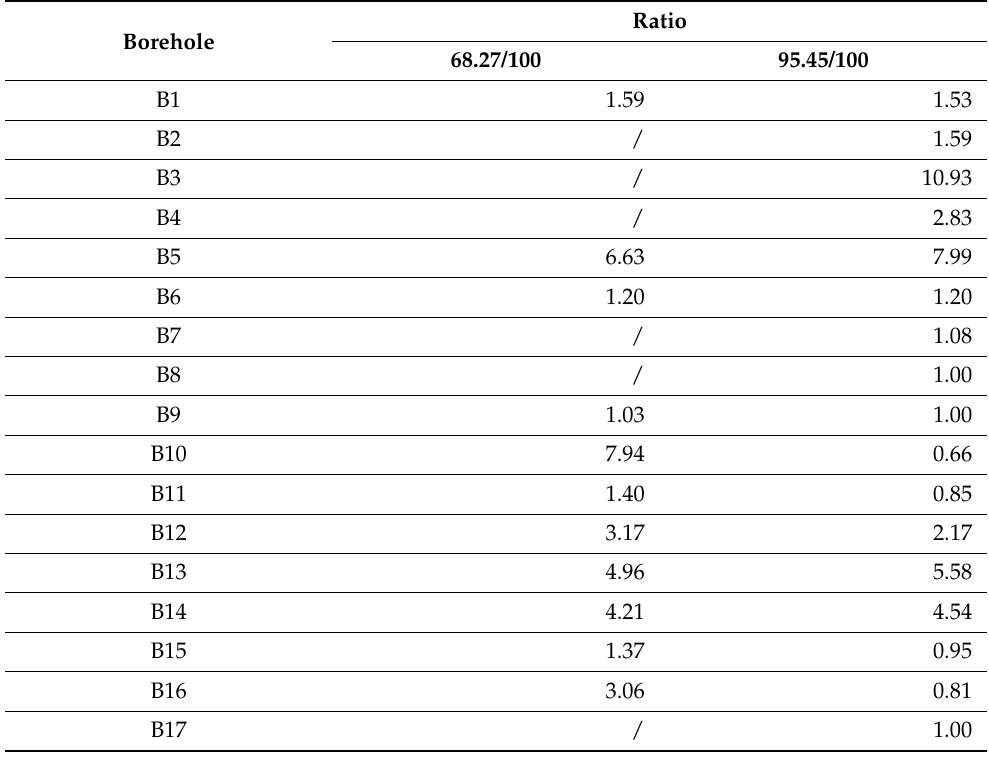
Table 7. Ratio between both confidence intervals (68.27% and 95.45%) and the full dataset for all 17 blast